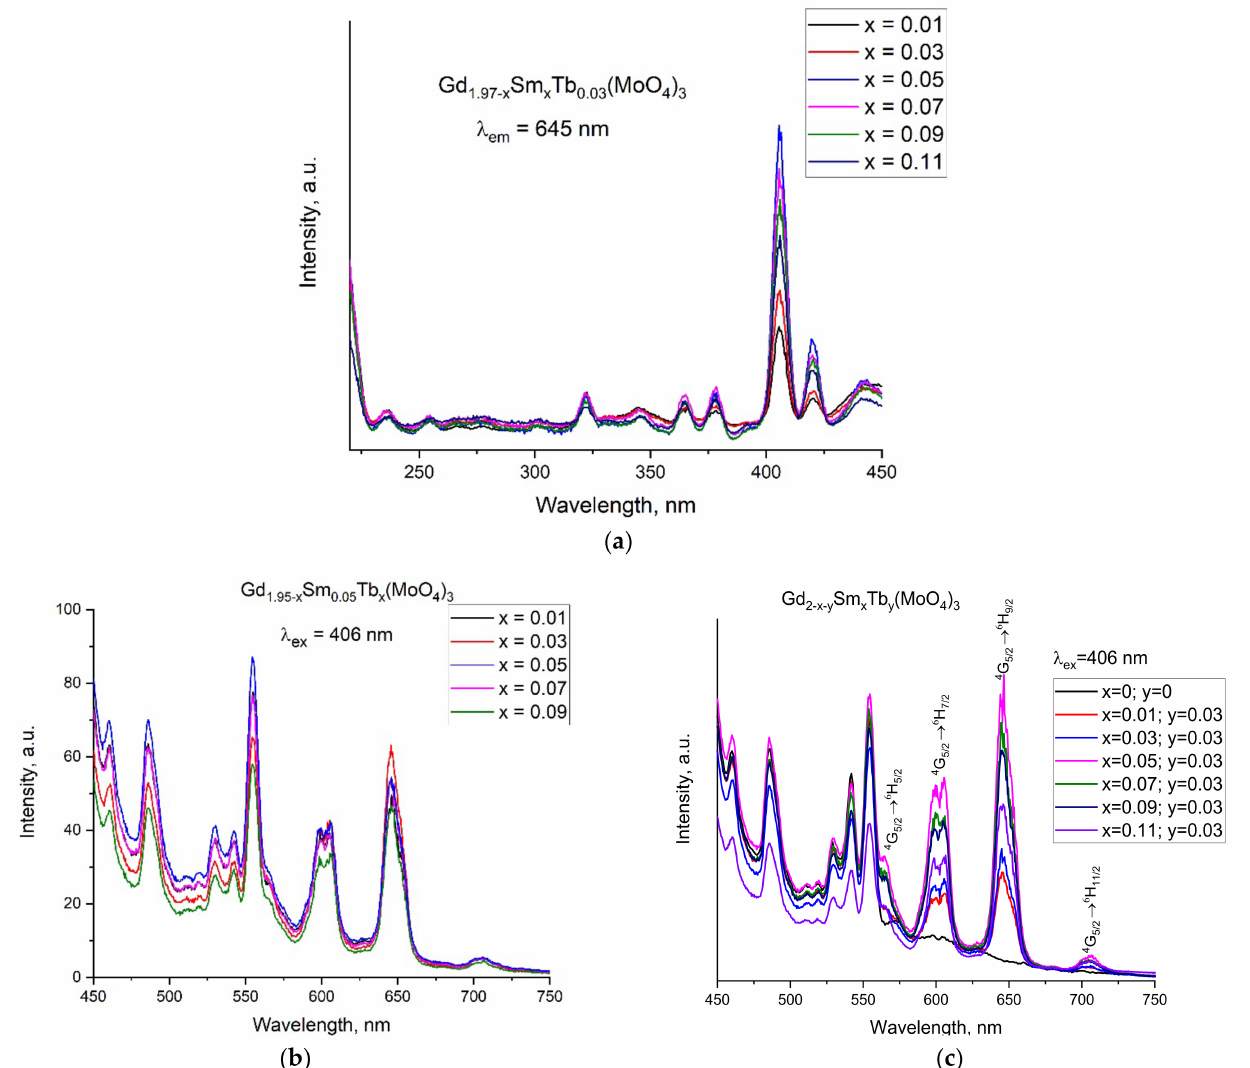
Figure 4. ( a ) Excitation spectra of the Gd 1.97 − x Sm x Tb 0.03 (MoO 4 ) 3 sample monitored at 645 nm and emission spectra of the samples ( b ) Gd 1.95 − x Sm 0.05 Tb x (MoO 4 ) 3 and ( c ) Gd 2 − x − y Sm x Tb y (MoO 4 ) 3 upon excitation with a 406 nm